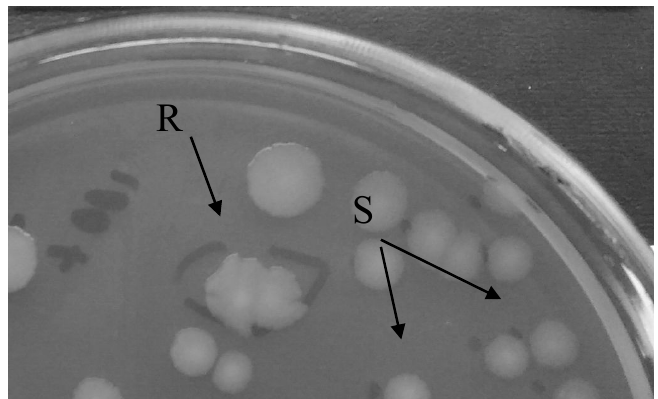
Figure 3. S and R forms colonies P. syringae pv. tomato IZ28 under the action of deltamethrin. Table 3. Morphological dissociation of P. syringae pv. tomato for deltamethrin action. Pesticide Concentration, Pesticide